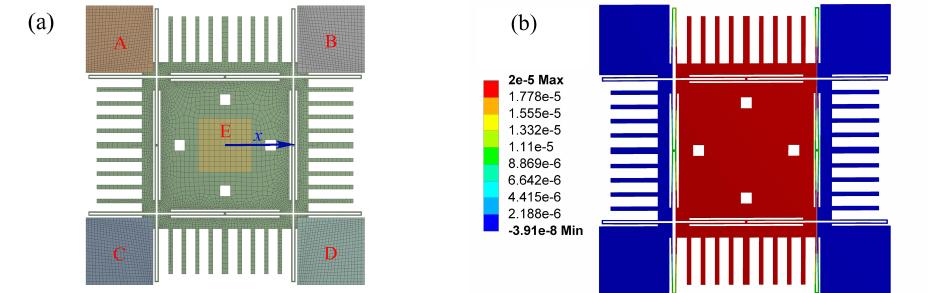
Figure 5. The finite element analysis of the restoring force (the displacement in the driving direction), where the displacement of the proof mass is x = 20 µ m, T = 300 K, θ = 0, and F re = 7.5151 × 10 − 3 N. ( a ) The FEA model, ( b ) The displacement